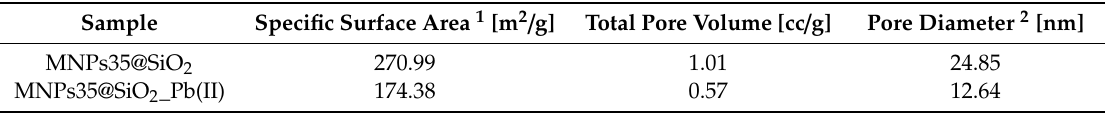
Table 6. Specific surface area, total pore volume and pore diameter of MNPs35@AM_SiO 2 before and after Pb 2+ ions adsorption.